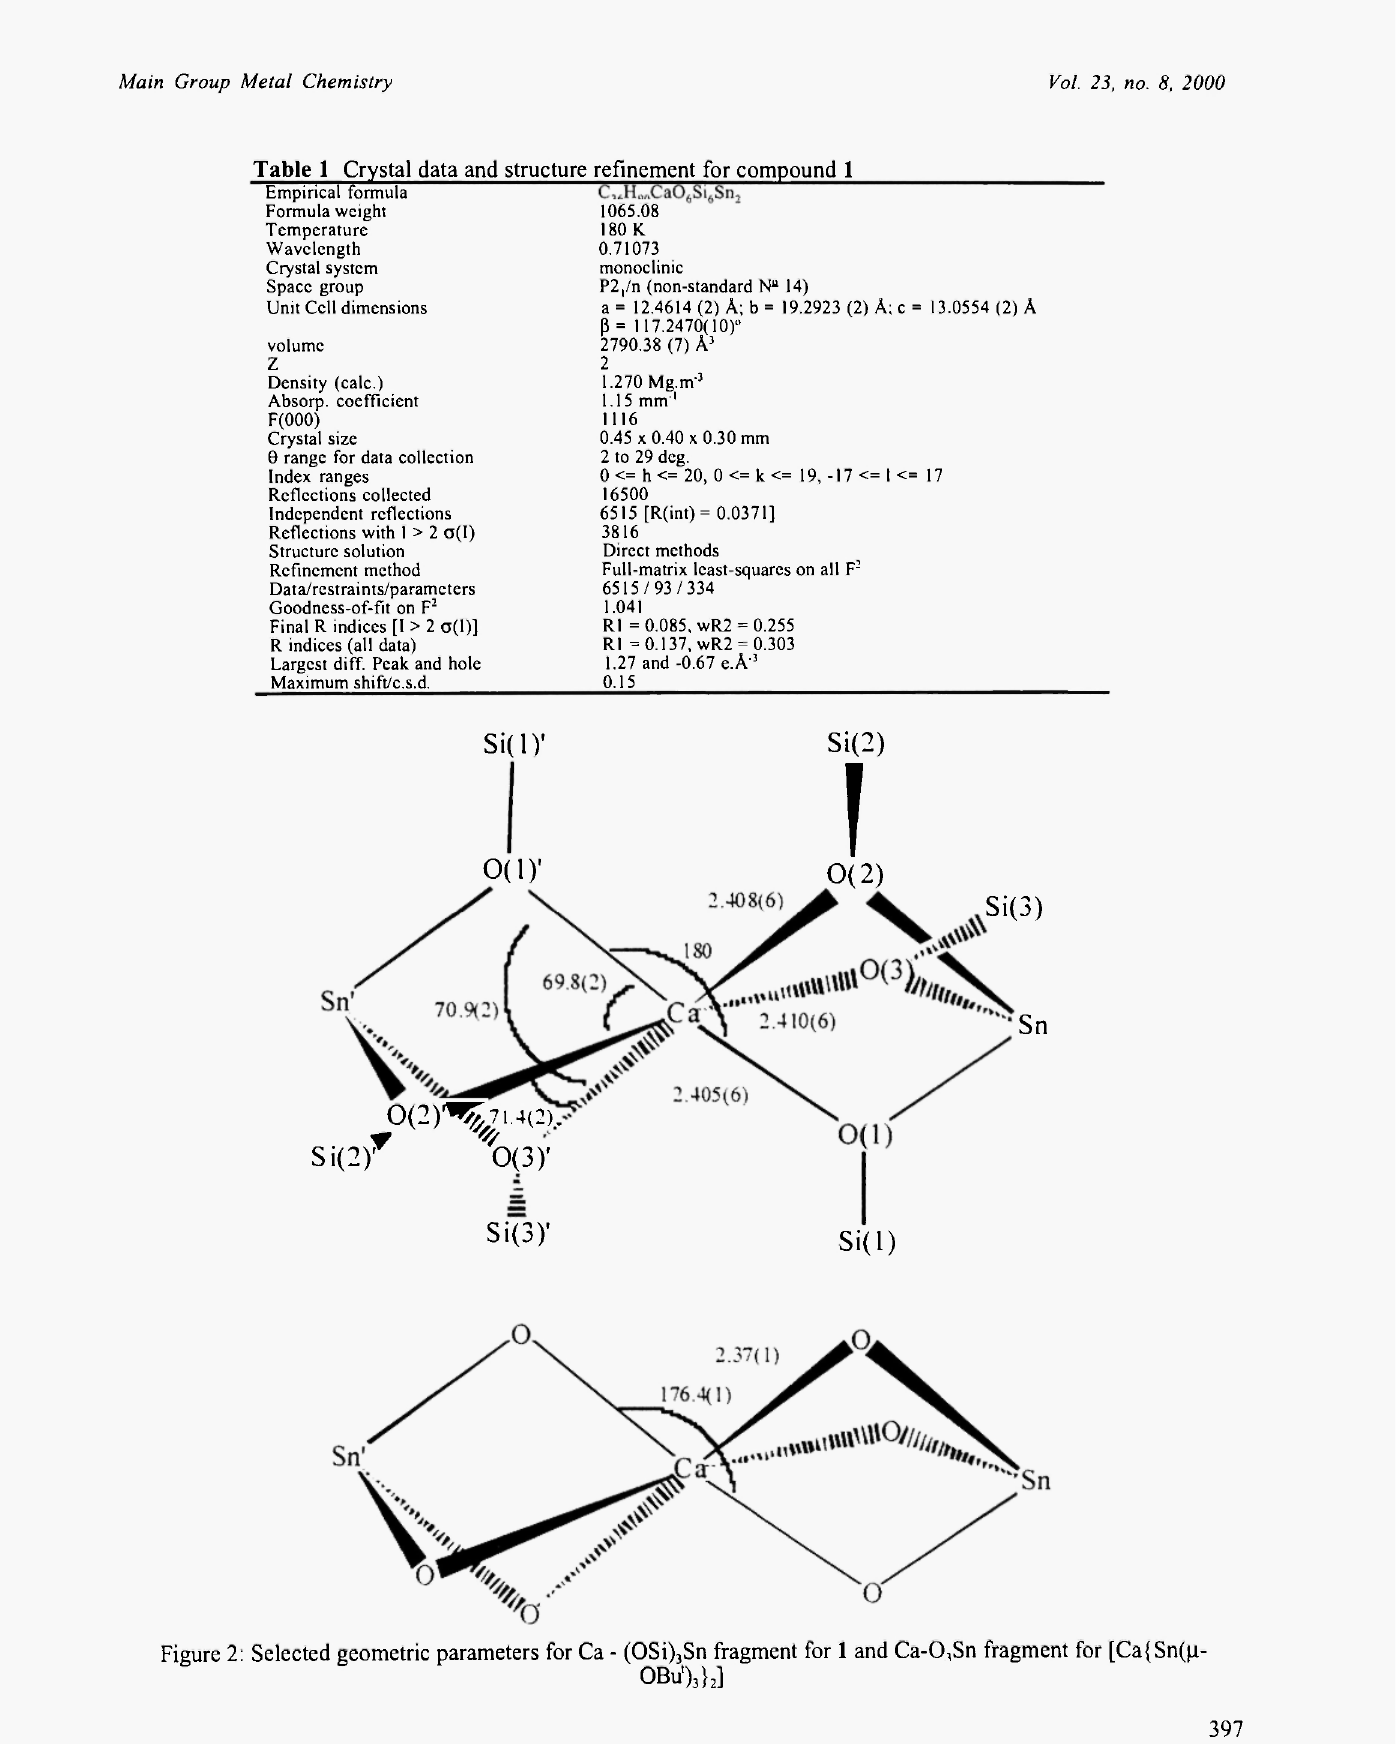
Table 1 Crystal data and structure refinement for compound 1 Empirical formula